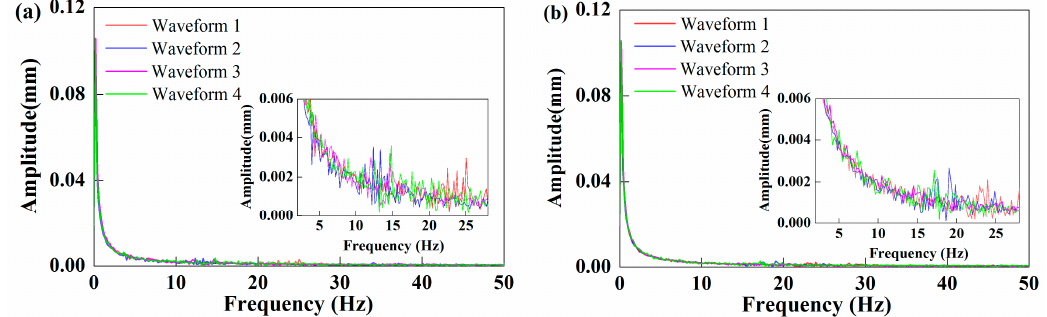
Figure 19. Amplitude frequency characteristics of measurements. ( a ) PB is the measured plane ( b ) PA is the measured plane.